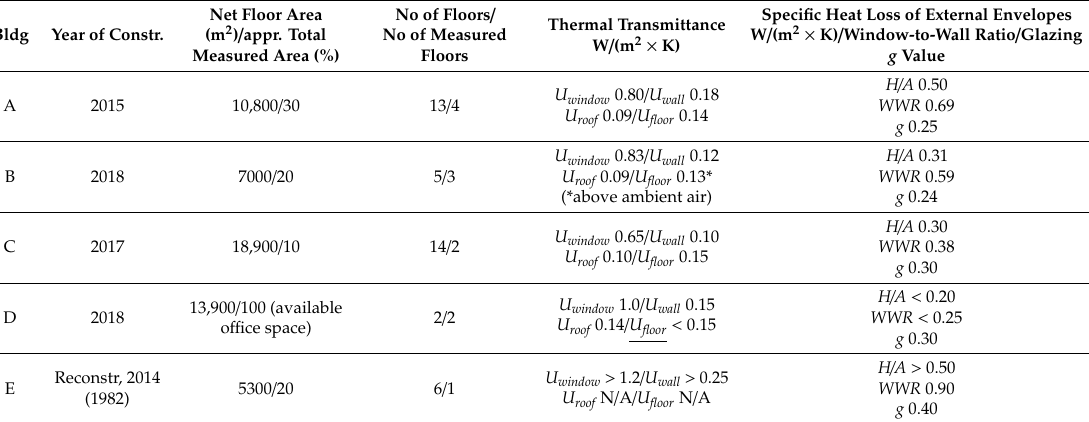
Table 1. General building information of reference objects.